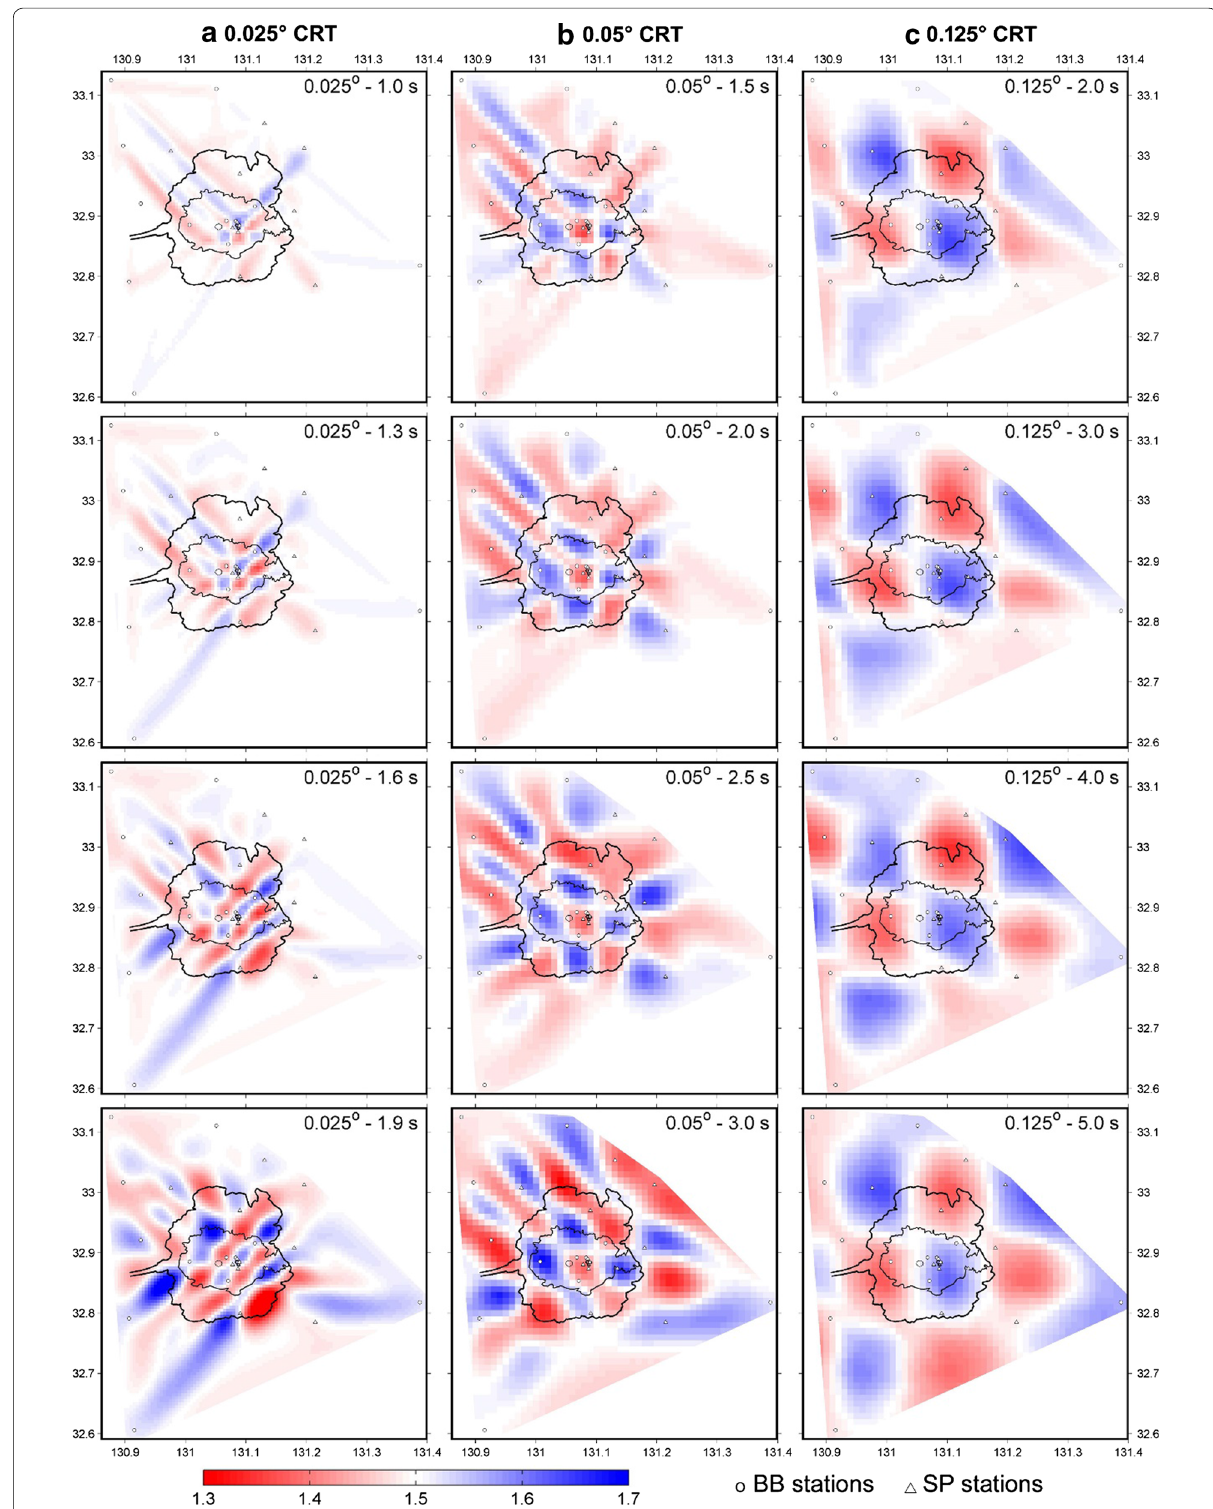
Fig. 11 Recovery for the three CRT models displayed in Fig. 10 for four separately selected periods: a 0.025° CRT model for periods 1.0, 1.3, 1.6, and 1.9 s; b 0.05° CRT model for periods 1.5, 2.0, 2.5, and 3.0 s; c 0.125° CRT model for periods 2.0, 3.0, 4.0, and 5.0